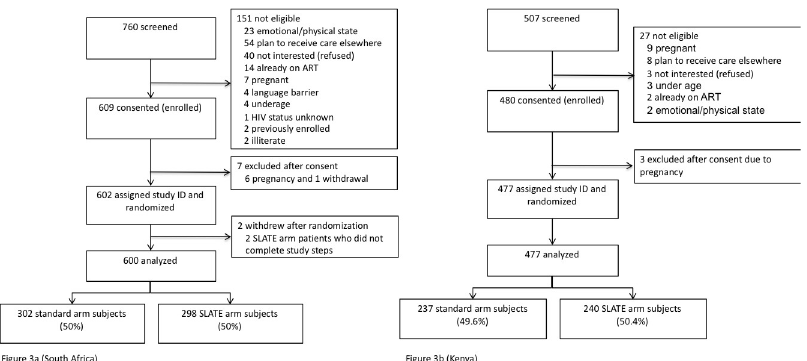
Fig 3. CONSORT flow diagram for the SLATE randomized trial of same-day treatment initiation. (a) South Africa; (b) Kenya. ART, antiretroviral therapy; SLATE, Simplified Algorithm for Treatment Eligibility.